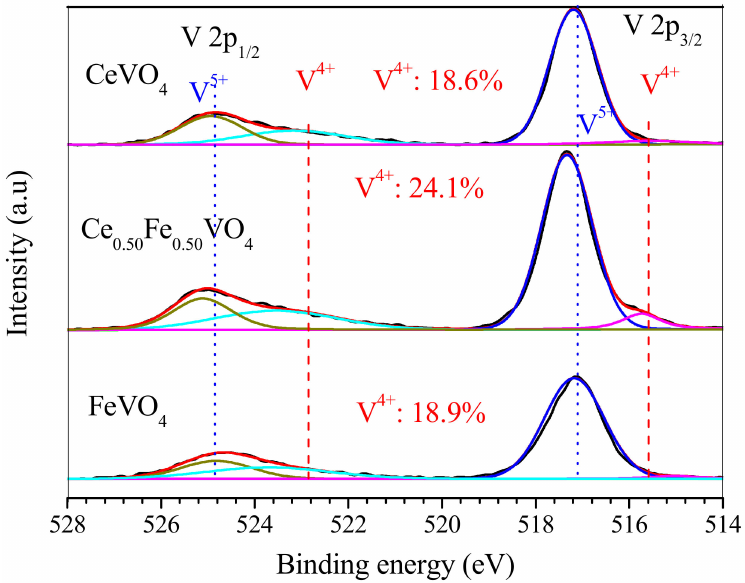
Figure 8. V 2p XPS spectra of CeVO 4 , Ce 0.50 Fe 0.50 VO 4 , and FeVO 4 .